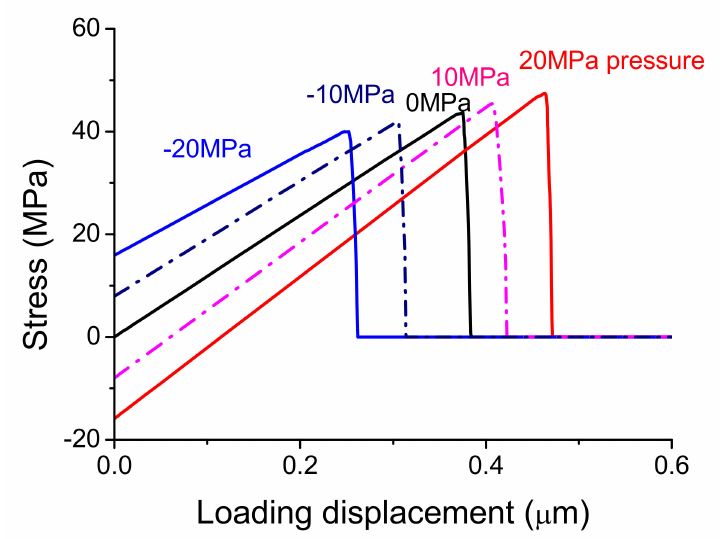
Figure 10. The residual pressure effects on the interface strength (peak stress) at tensile